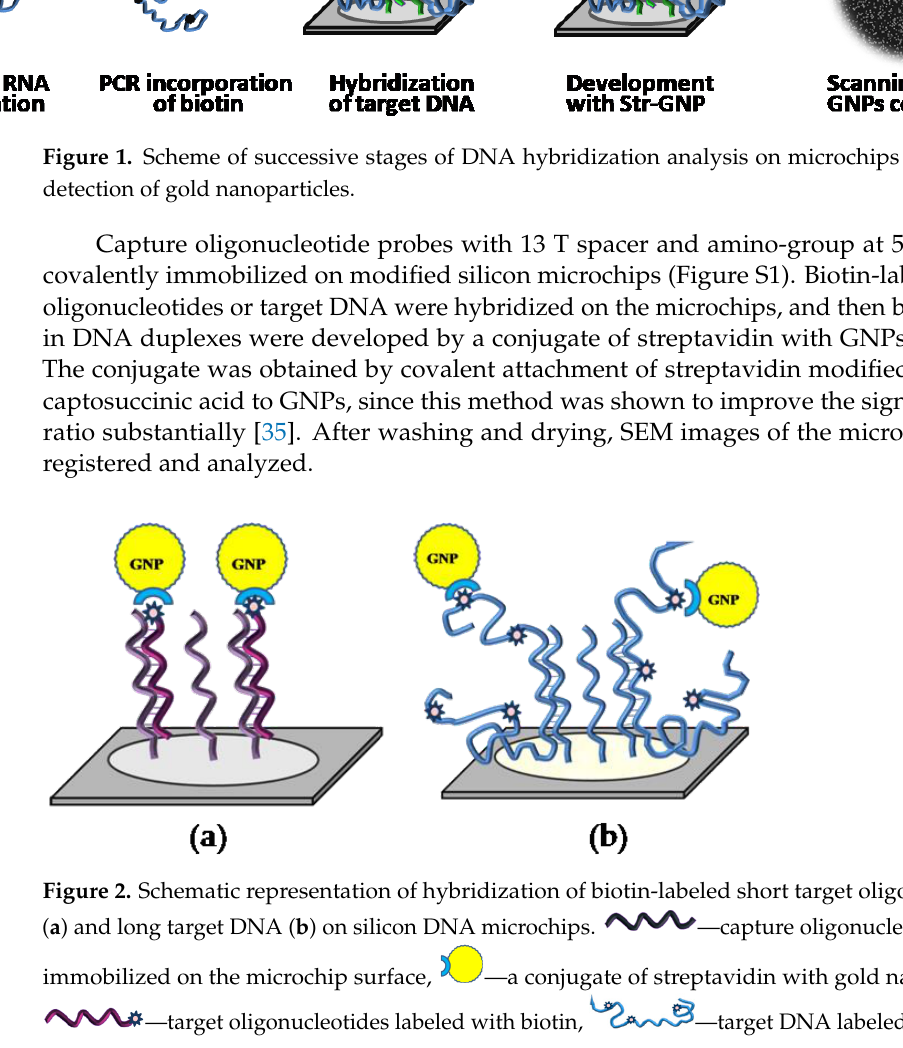
Figure 3. SEM images of the specific microchip spots after hybridization of 300 pM target Probe C with complementary Probe A ( a ) and non-complementary Probe B ( b ). Biotin in DNA duplexes was developed with a streptavidin – GNPs conjugate. Then, the SEM was applied for the characterization of long DNA hybridization. Two target DNAs were studied: 507 bp DNA, coding a large fragment of bla VIM-1 , and 870 bp DNA, coding the whole-length bla CTX-M-3 . Several capture oligonucleotide probes were spotted on the microchip surface: two specific probes (Probe VIM and Probe CTX-M) and Probe B as a negative control. After hybridization with the target DNA, biotin labels were revealed by the conjugate streptavidin – GNPs as described above, followed by the regis- tration of GNPs with SEM. Similarly to the hybridization of the short oligonucleotide, in- dividual nanoparticles were recorded clearly on SEM images of the spots with comple- mentary duplexes of target DNA and specific immobilized probes. The number of nano- particles registered on the negative control spots was negligible. Long DNA biopolymer molecules were present in the hybridization medium in a folded conformation, depending on the ionic strength and salt concentration. Since it may have reduced the hybridization effectiveness, we investigated the addition of magnesium chloride and SDS to promote their unfolding. The effect of MgCl 2 and SDS concentrations on the GNP density registered on the specific spots is shown in Figure S2 (Supplementary Materials). The number of particles detected was dependent on the concentration of mag- nesium ions, and the dependence was bell-shaped (Figure S2a). Although the flatness of the curve maximum depended on the type of gene, we chose a concentration of 6mM magnesium ions, at which the number of nanoparticles on the surface increased as much